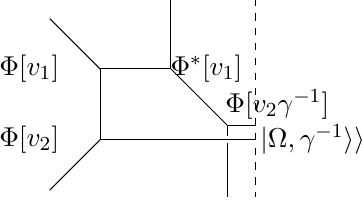
Figure 6 . The vertex assignment for the D 2 quiver